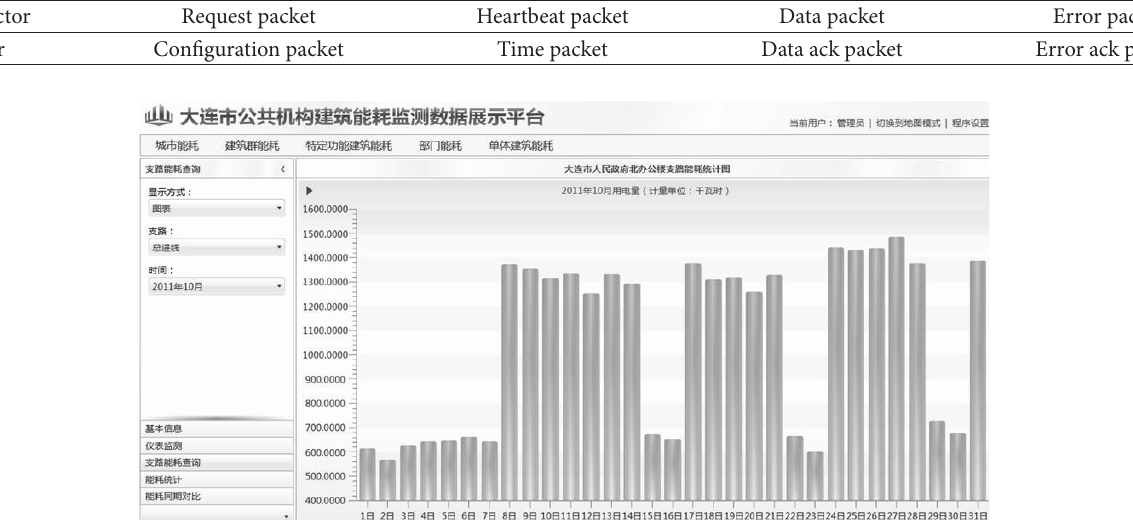
Figure 10: Electrical daily load of